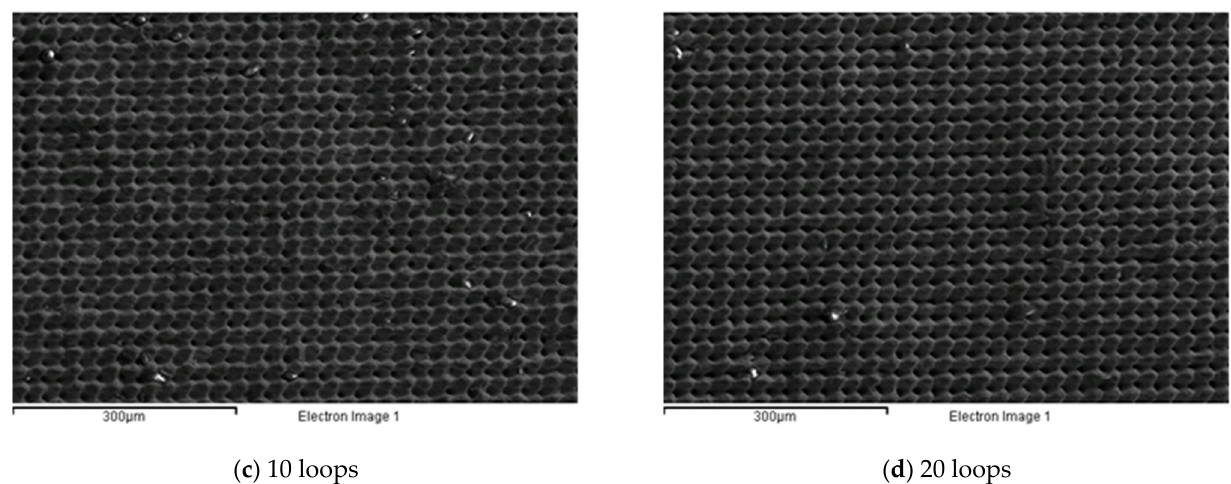
Figure 9. Morphological analysis for the third experimental series. ( a ) 1 loop; ( b ) 5 loops; ( c ) 10 loops; ( d ) 20 loops.